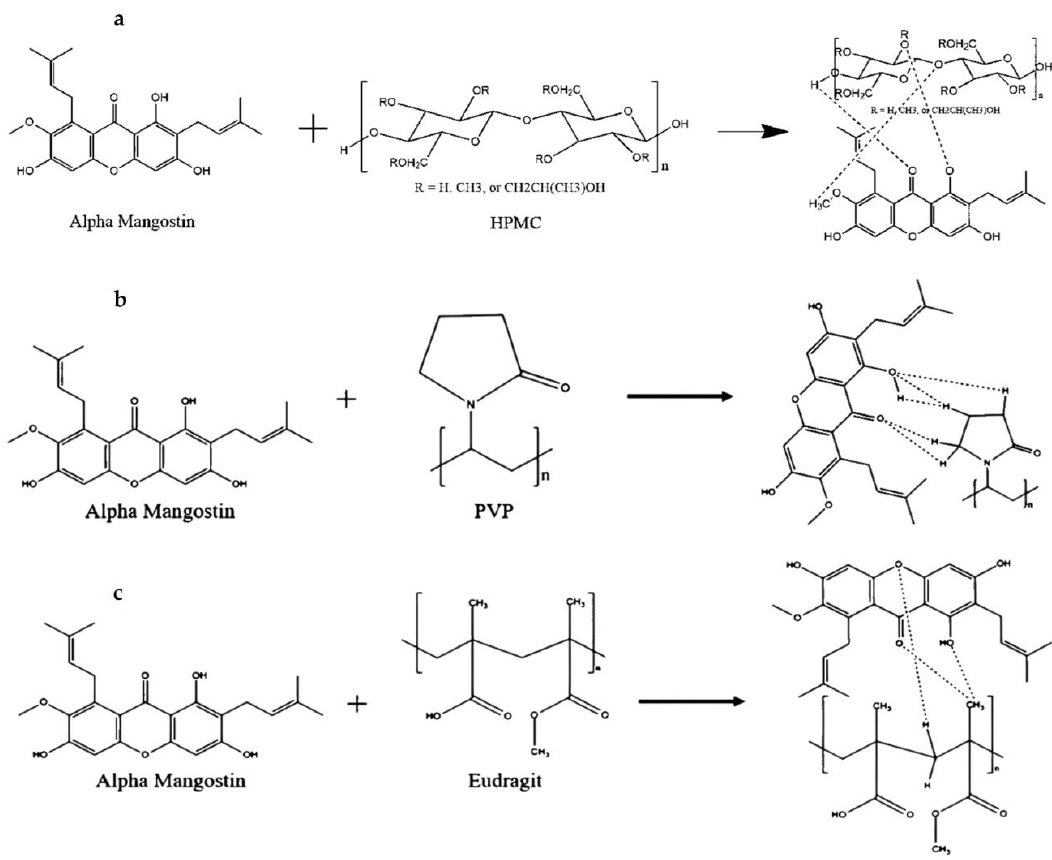
Figure 10. 2D Visualization of AM with ( a ) HPMC, ( b ) PVP, and ( c ) eudragit.